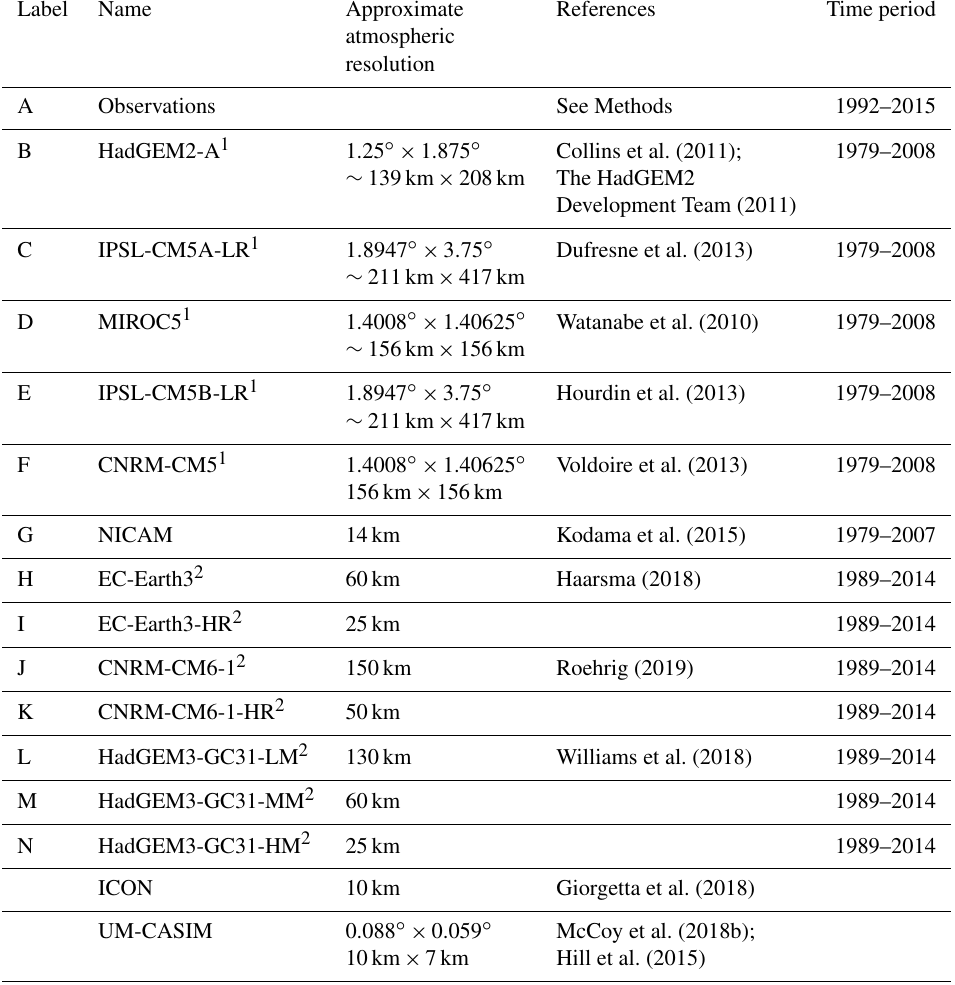
Table 2. Brief descriptions of the models used in this study. The label in the left column is used in some figures for brevity in labeling. The observations used in this study are discussed more completely in the Methods